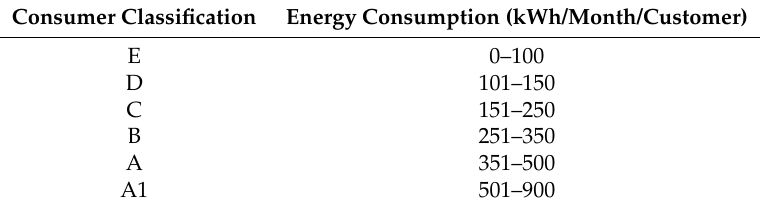
Table 1. Consumer classification by energy